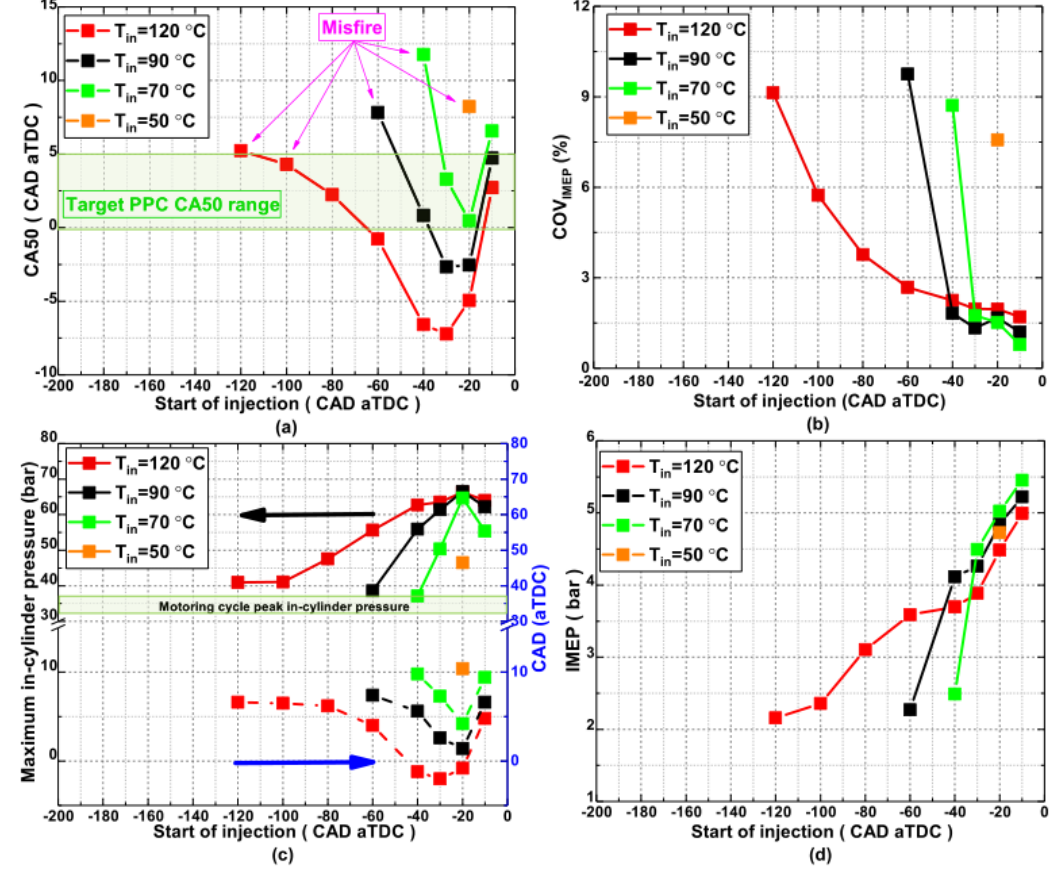
Fig. 7 Effect of temperature and SOI on combustion characteristics. (a) CA50 (b) CoV (c) maximum in-cylinder pressure (d) IMEP